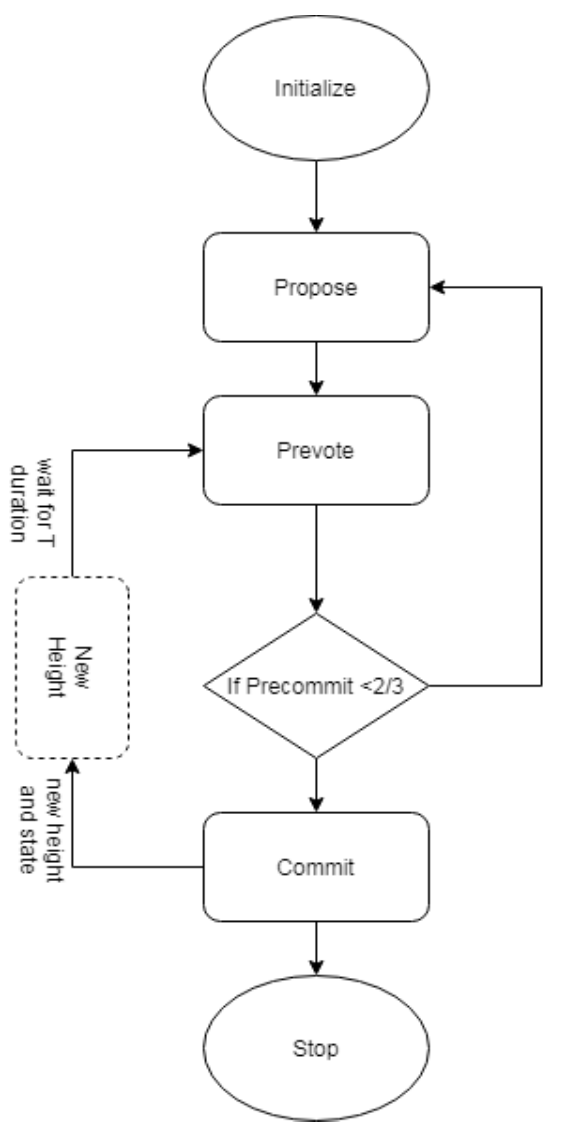
Figure 5. Consensus algorithm without mining used by Tendermint.